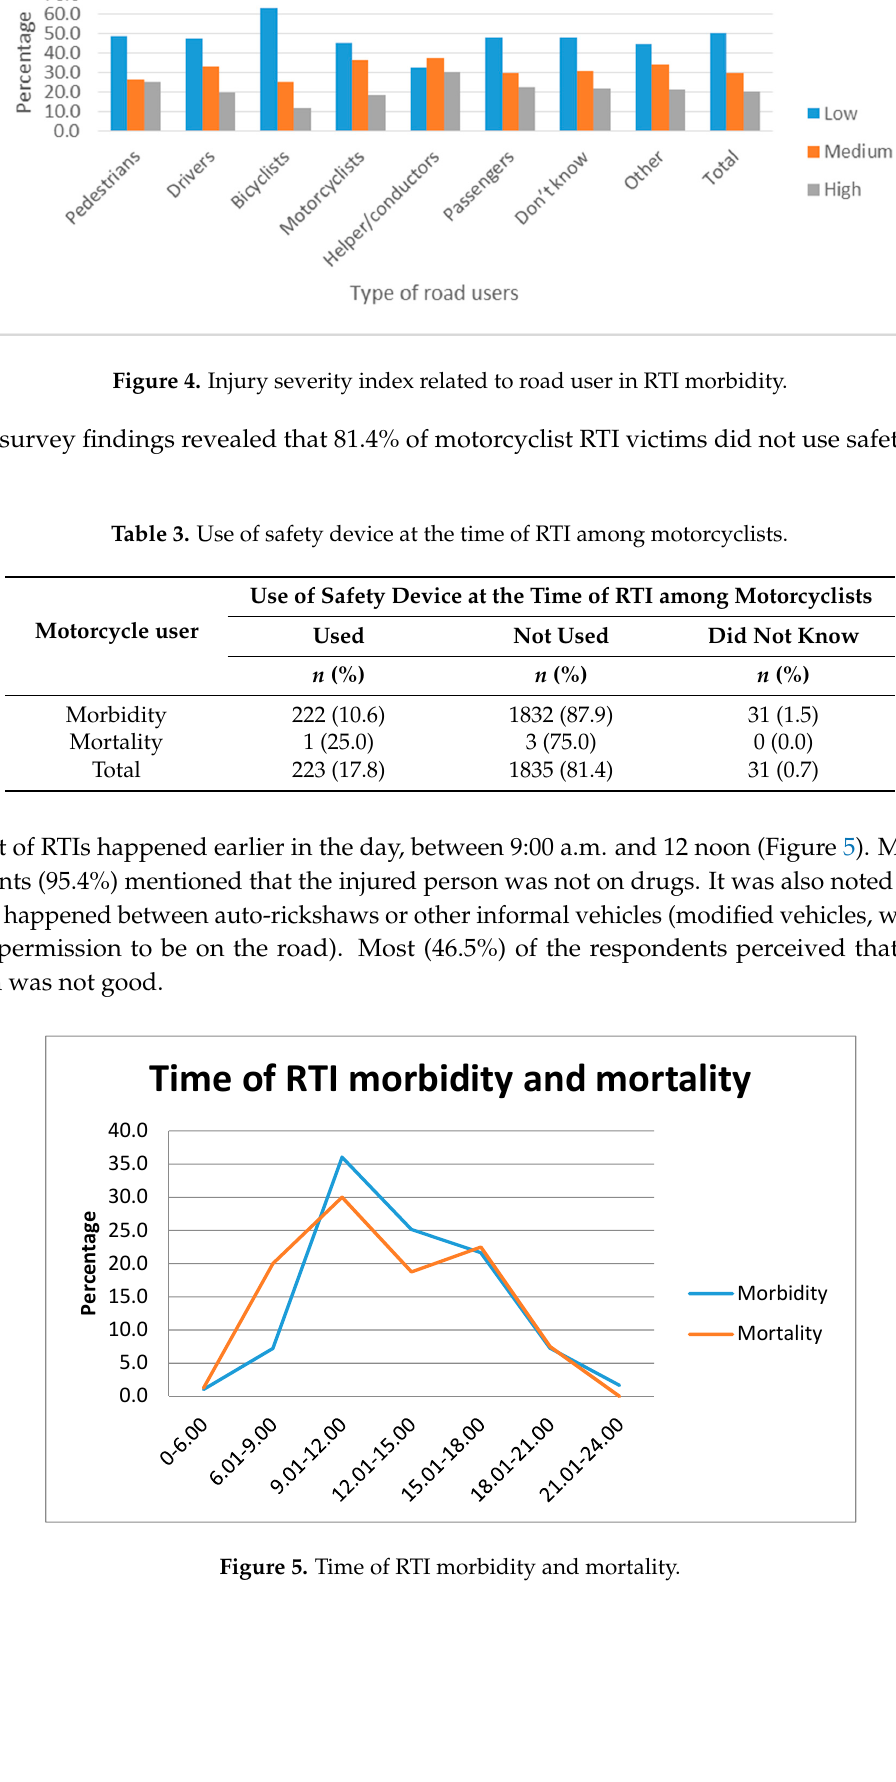
Figure 5. Time of RTI morbidity and mortality.